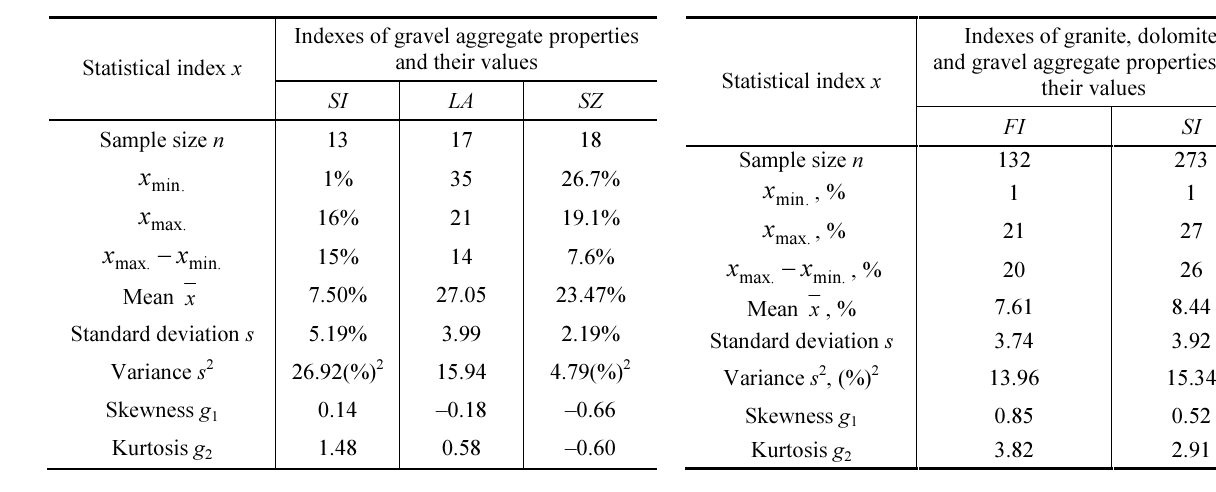
Table 4. Summary of mechanical indexes FI and SI of all researched strains (granite, dolomite and